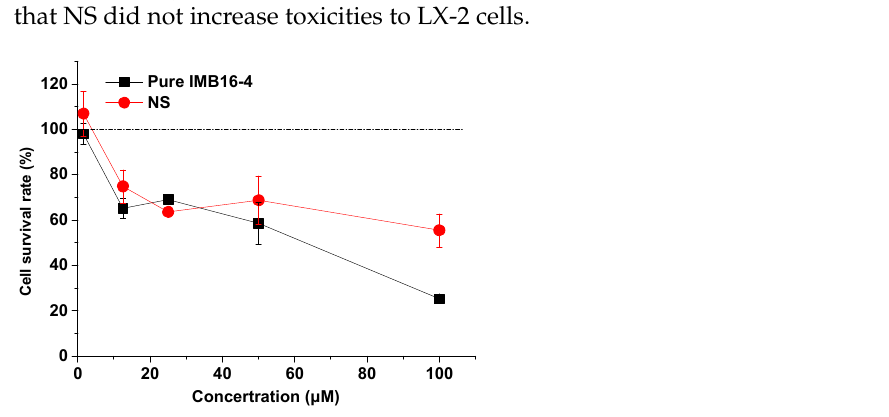
Figure 8. The cell survival rate of LX-2 cells at varying concentrations of pure IMB16-4 and NS. Each data point represents the mean ± SD of three determinations.